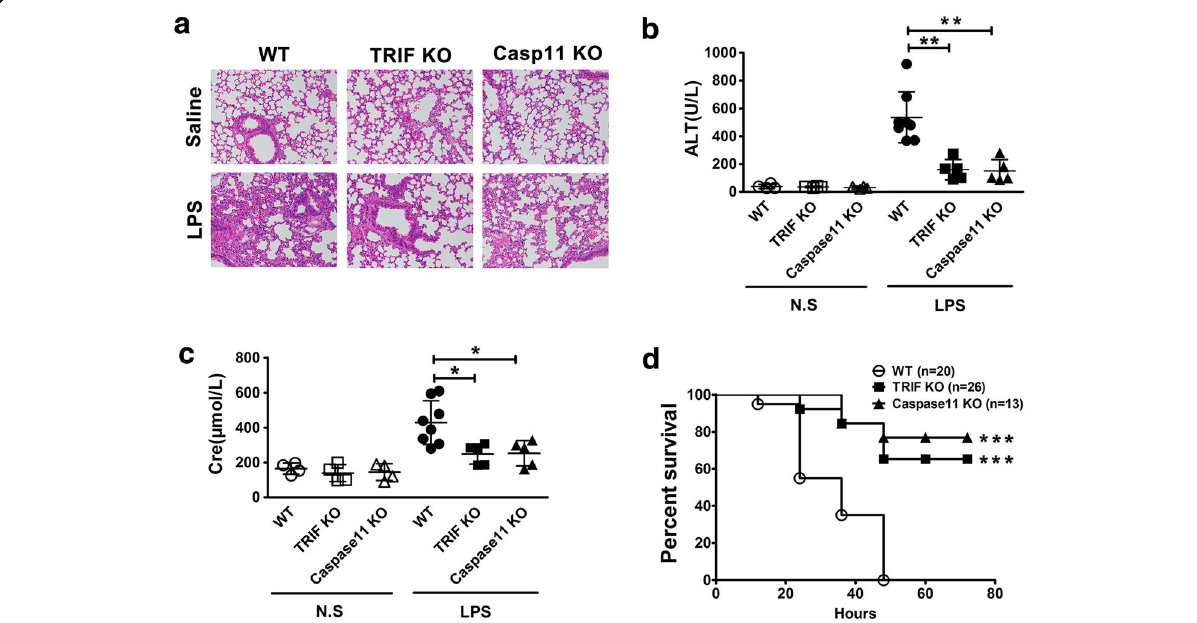
Fig. 2 TRIF is required for caspase-11-dependent organ injury and lethality in endotoxemia. a Histology of the lungs from mice of indicated genotypes ( n = 5) following intraperitoneal injection with either 10 mg/kg LPS or saline. Lungs were collected 8 h after LPS injection and then stained with H&E. b-c The serum alanine aminotransferase (ALT) and creatinine (Cre) levels from mice of indicated genotypes following intraperitoneal injection with either 10 mg/kg LPS or saline. Serum samples were collected 8 h after LPS injection. d Kaplan Meier survival curves for the indicated genotypes mouse strains subjected to 40 mg/kg LPS injection. * P <0.05; ** P <0.01; *** P <0.001 (Student ’ s t-test and log-rank test for survival). Graphs show the mean ± SD. Data are representative of at least three independent